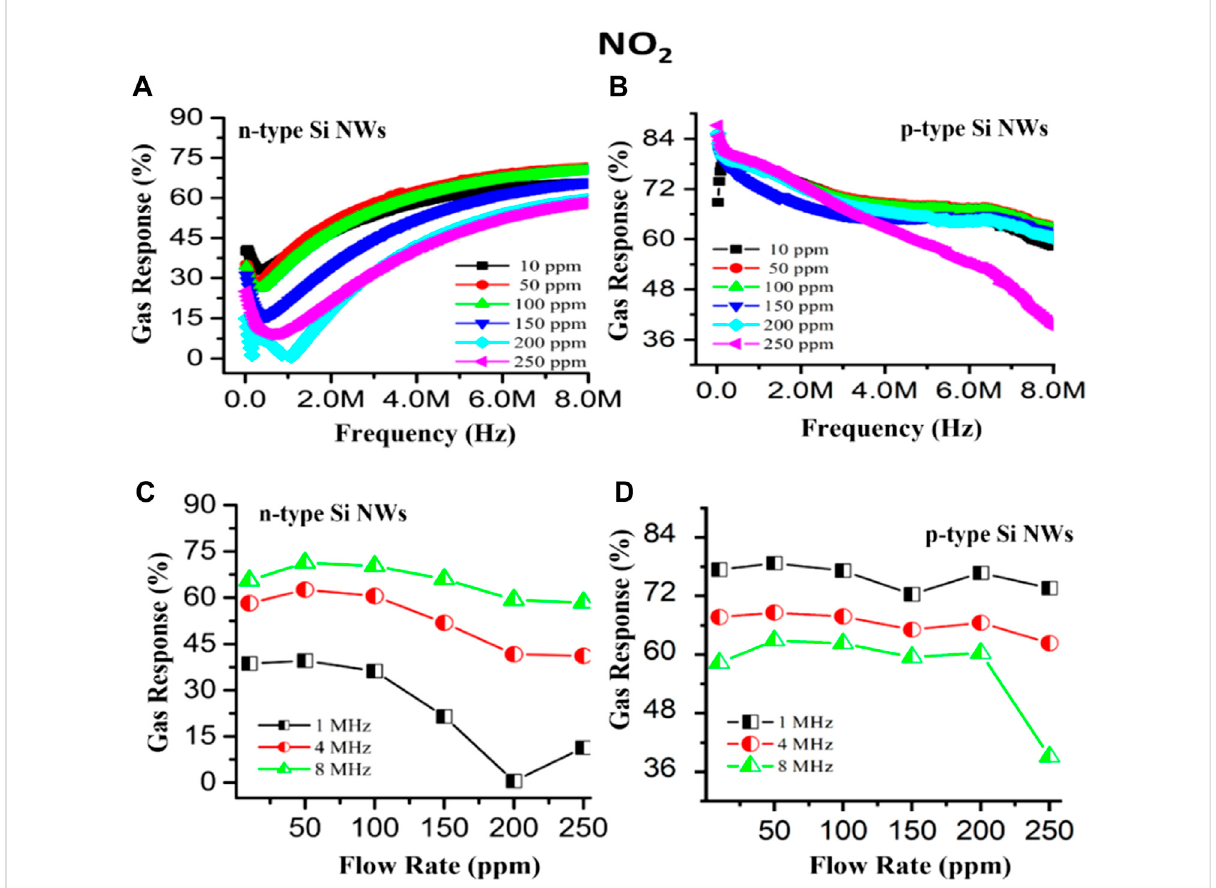
FIGURE 13 Gas-sensingresponseasafunctionoffrequencywithvaryingconcentrationsfor (A) then 40 SiNWand (B) thep 40 SiNWandat fi xedfrequencies with varying NO 2 gas concentrations for (C) the n 40 Si NW and (D) the p 40 Si NW at room temperature,